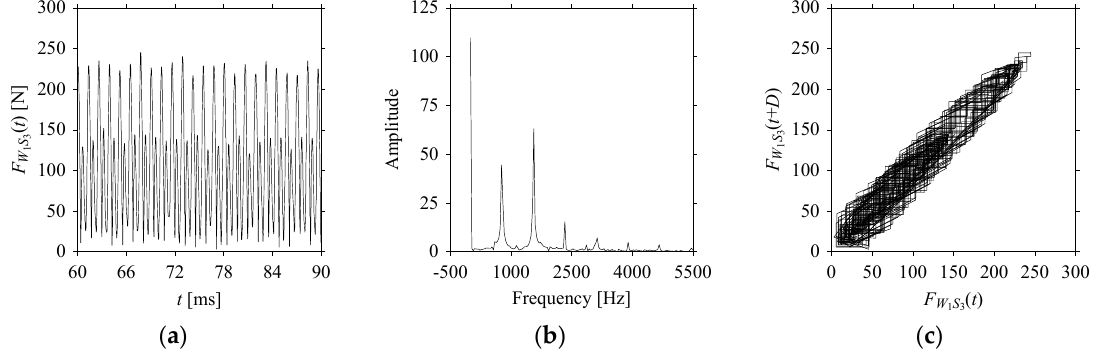
Figure 11. F W in the form of: ( a ) time series, ( b ) fast Fourier Transformation (FFT), and ( c ) delay map ( d = 1). 1 S 3